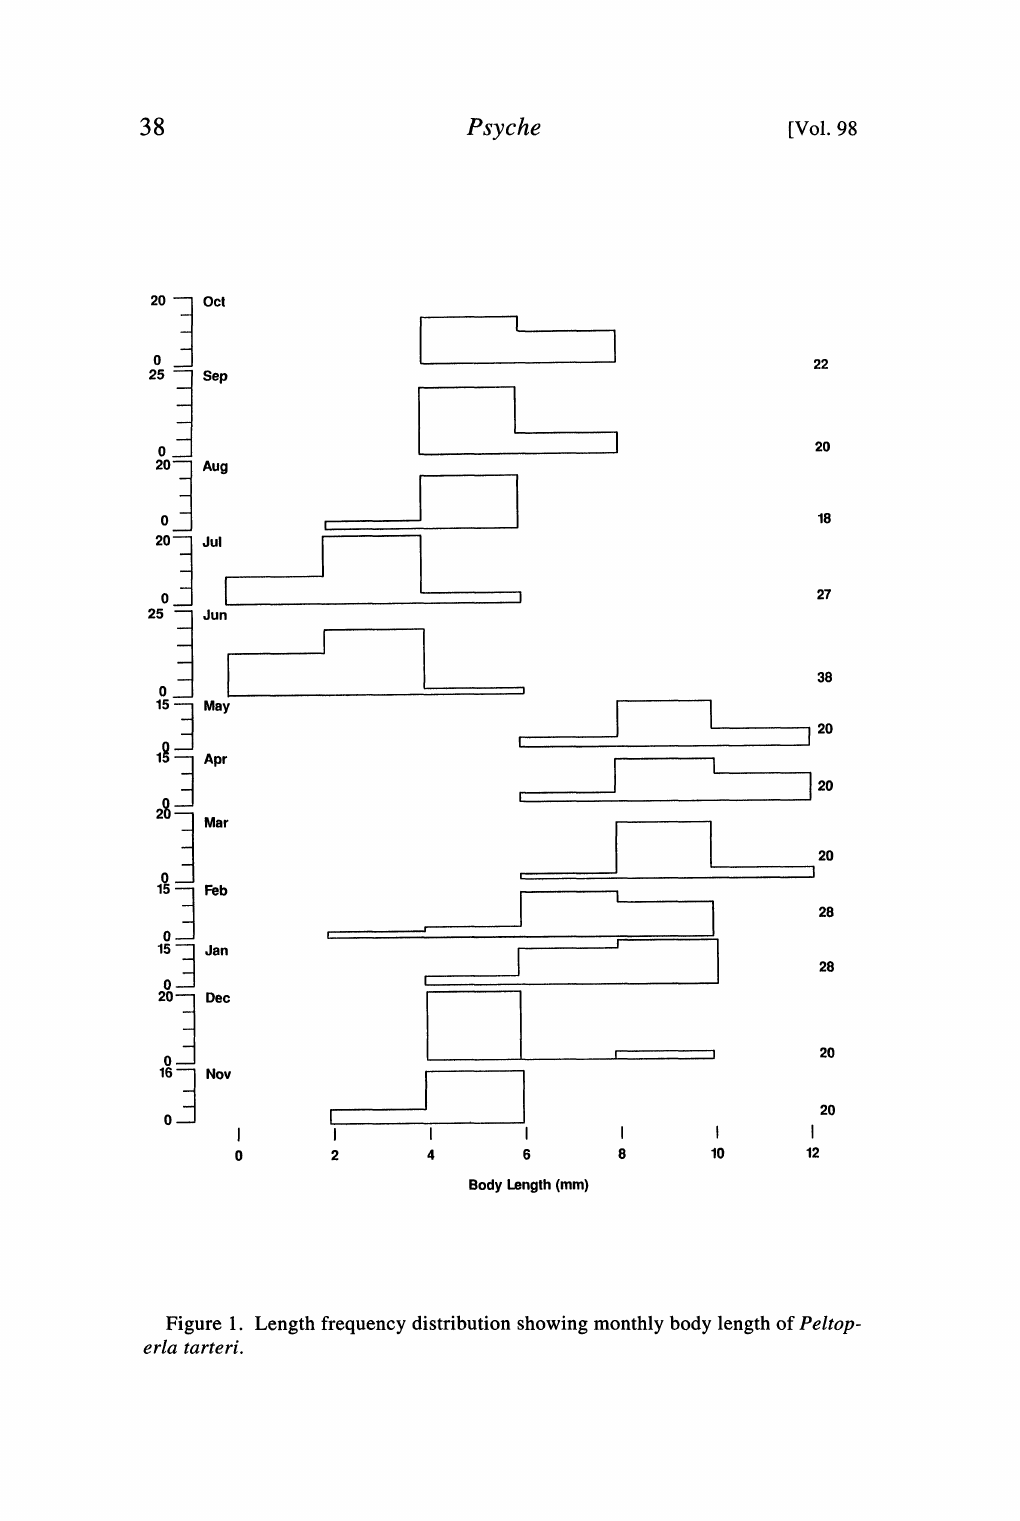
Figure 1. Length frequency distribution showing monthly body length of Peltop- erla